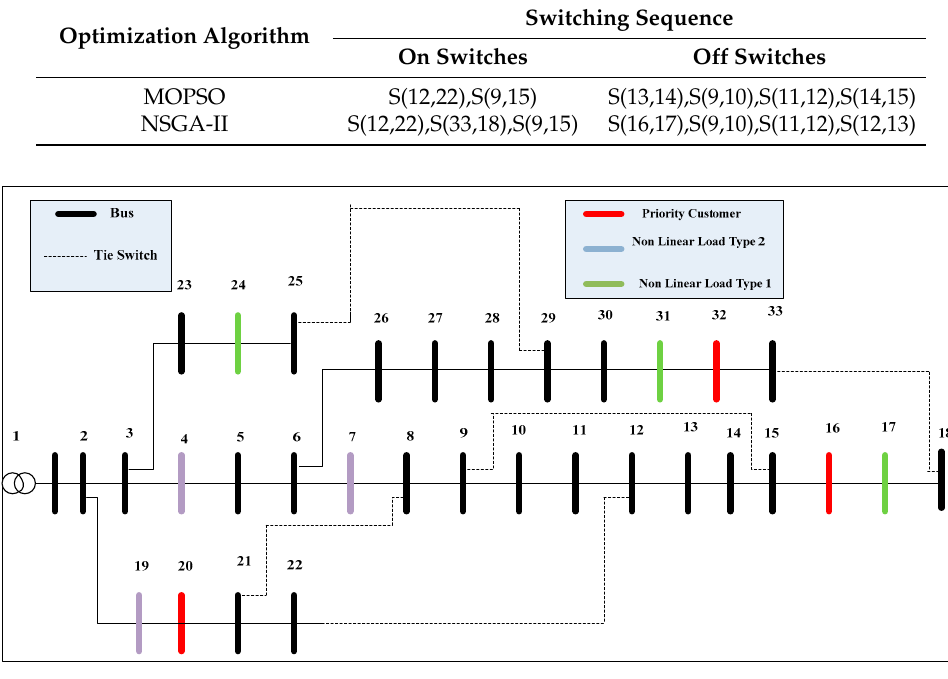
Figure 7. IEEE 33 bus test system.